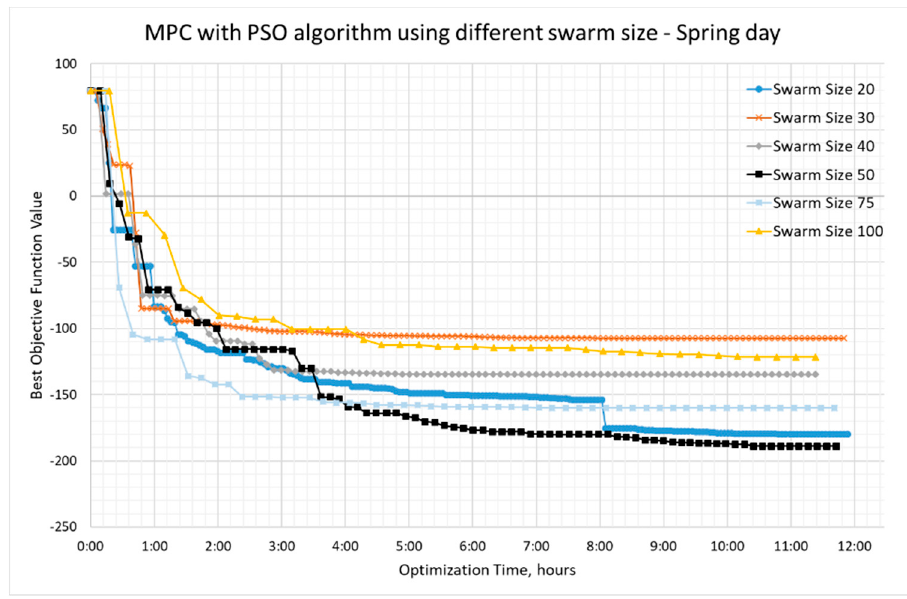
Figure 8. PSO optimization results on the spring day with different swarm size.